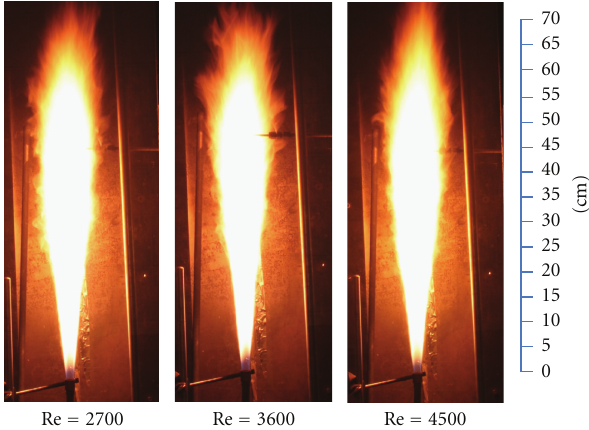
Figure 2: Photographs of the CME B50 flames at three Reynolds